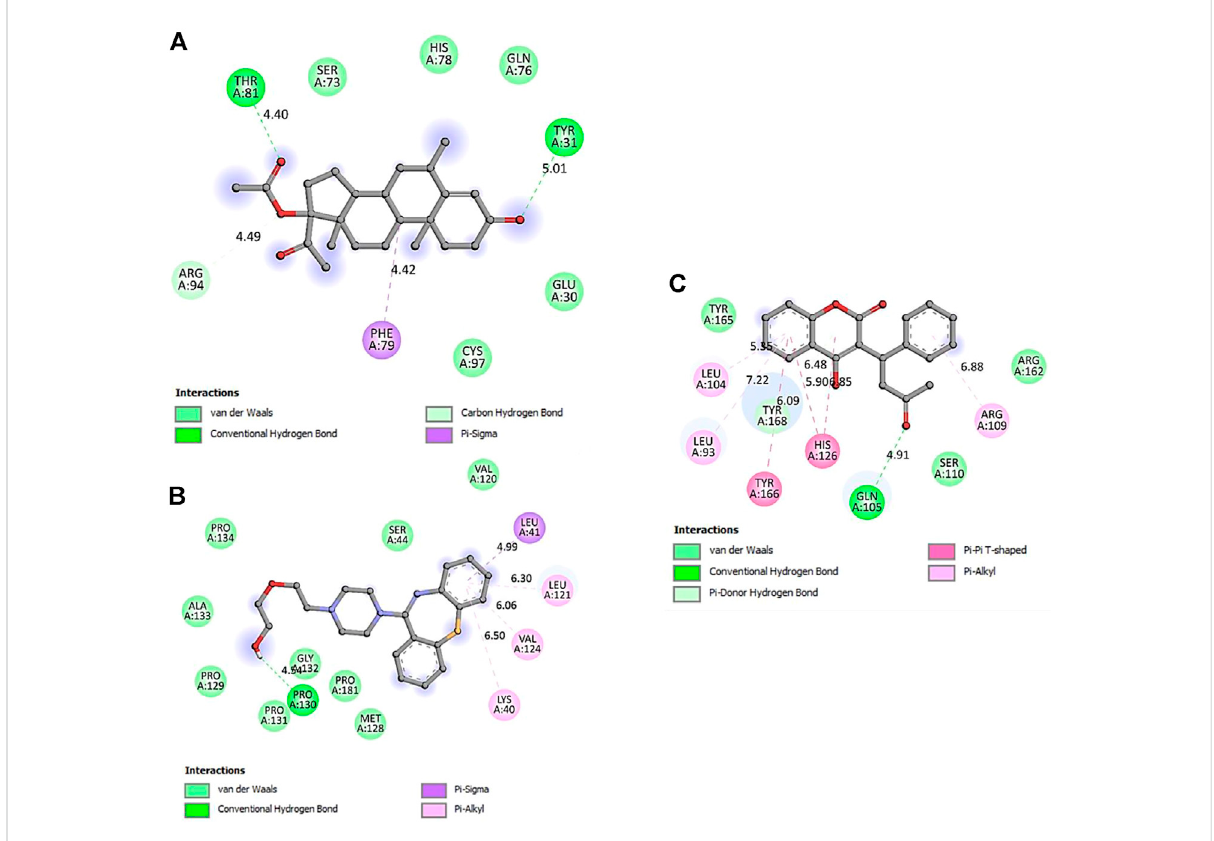
FIGURE 9 2D representation of SOCS3 protein-interacting residues in complexed with. (A) - Medroxyprogesterone Acetate, (B) - Quetiapine, and (C) -